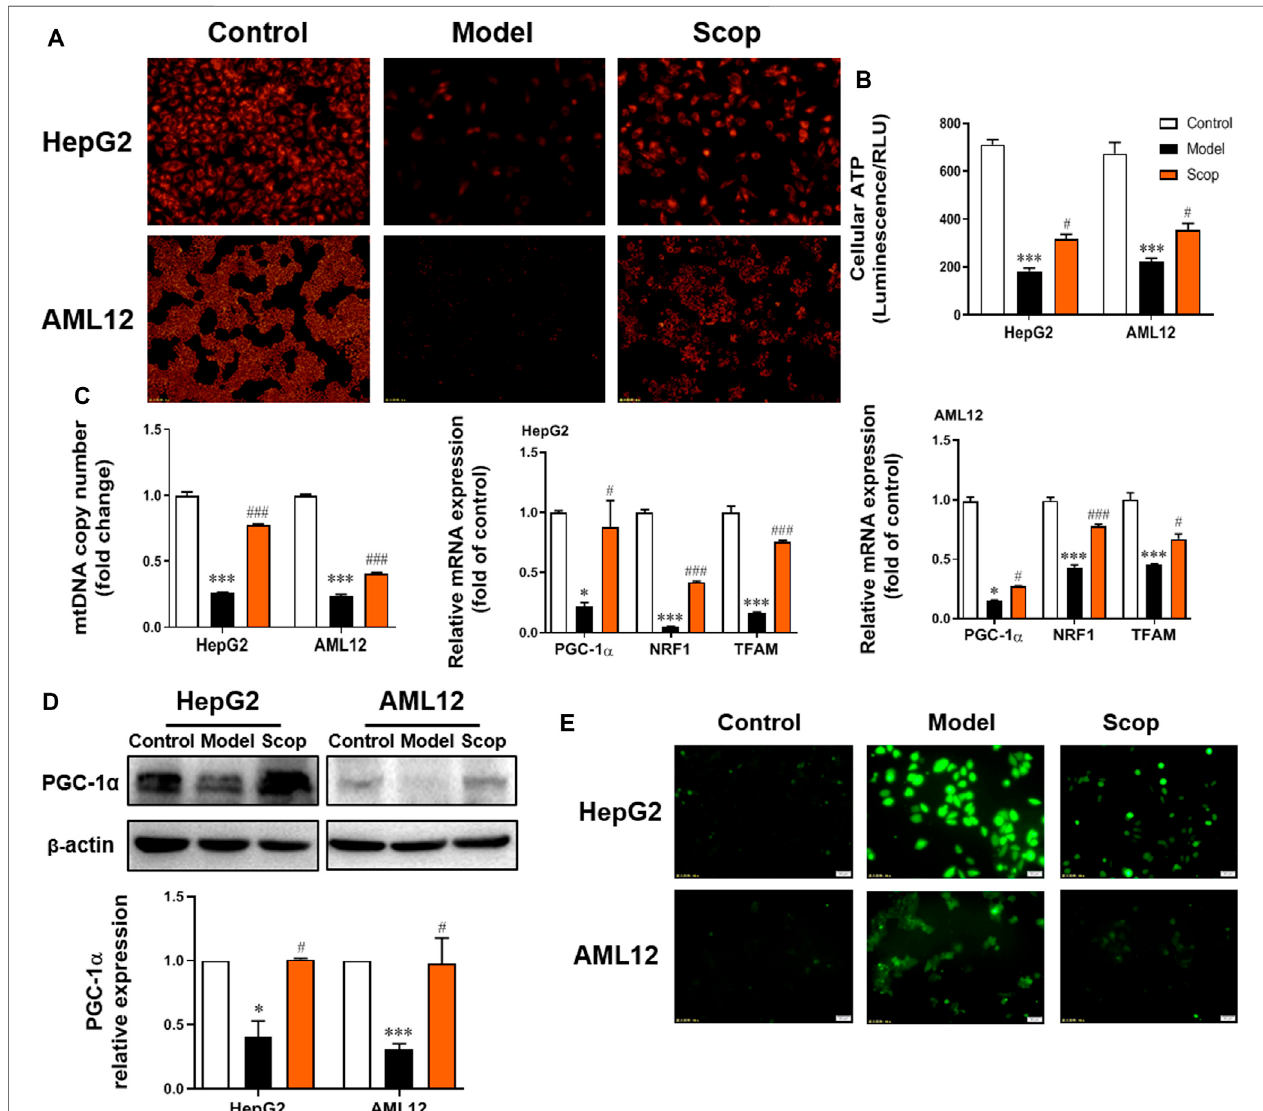
FIGURE 4 | Scoparone improved PA-induced mitochondrial dysfunction in hepatocytes. (A) TMRM staining (200×). (B) The ATP content of hepatocytes. (C) The mRNA level of mtDNA, PGC-1 α , NRF1, TFAM in HepG2 and AML12 cells. (D) The effect of Scoparone on PGC-1 α protein level in HepG2 and AML12 cells. (E)